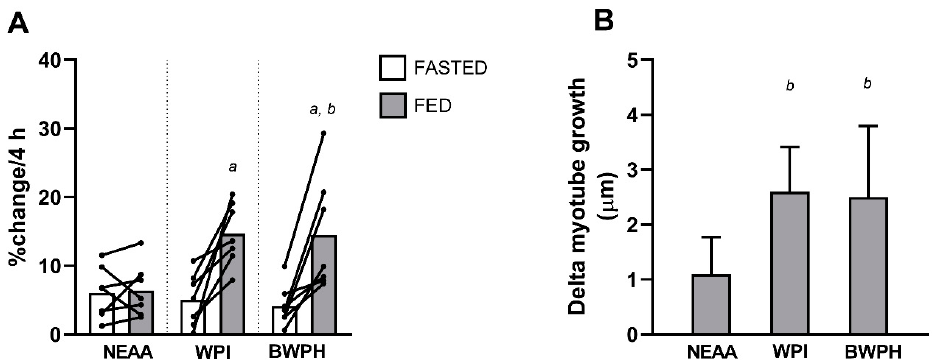
Figure 4. ( A ) Percentage change in myotube thickness following 4 h incubation with FASTED or FED (non-essential amino acid, NEAA; whey protein isolate, WPI; blue whiting protein hydrolysate, BWPH) human-conditioned serum. ( B ) Delta myotube growth ( µ m) in each condition. a Significantly different from FASTED, b significantly different from NEAA-fed.